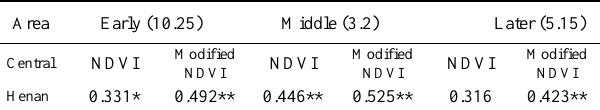
Table 2. Correlations of NDVI, modified NDVI and soil moisture of 10cm in central